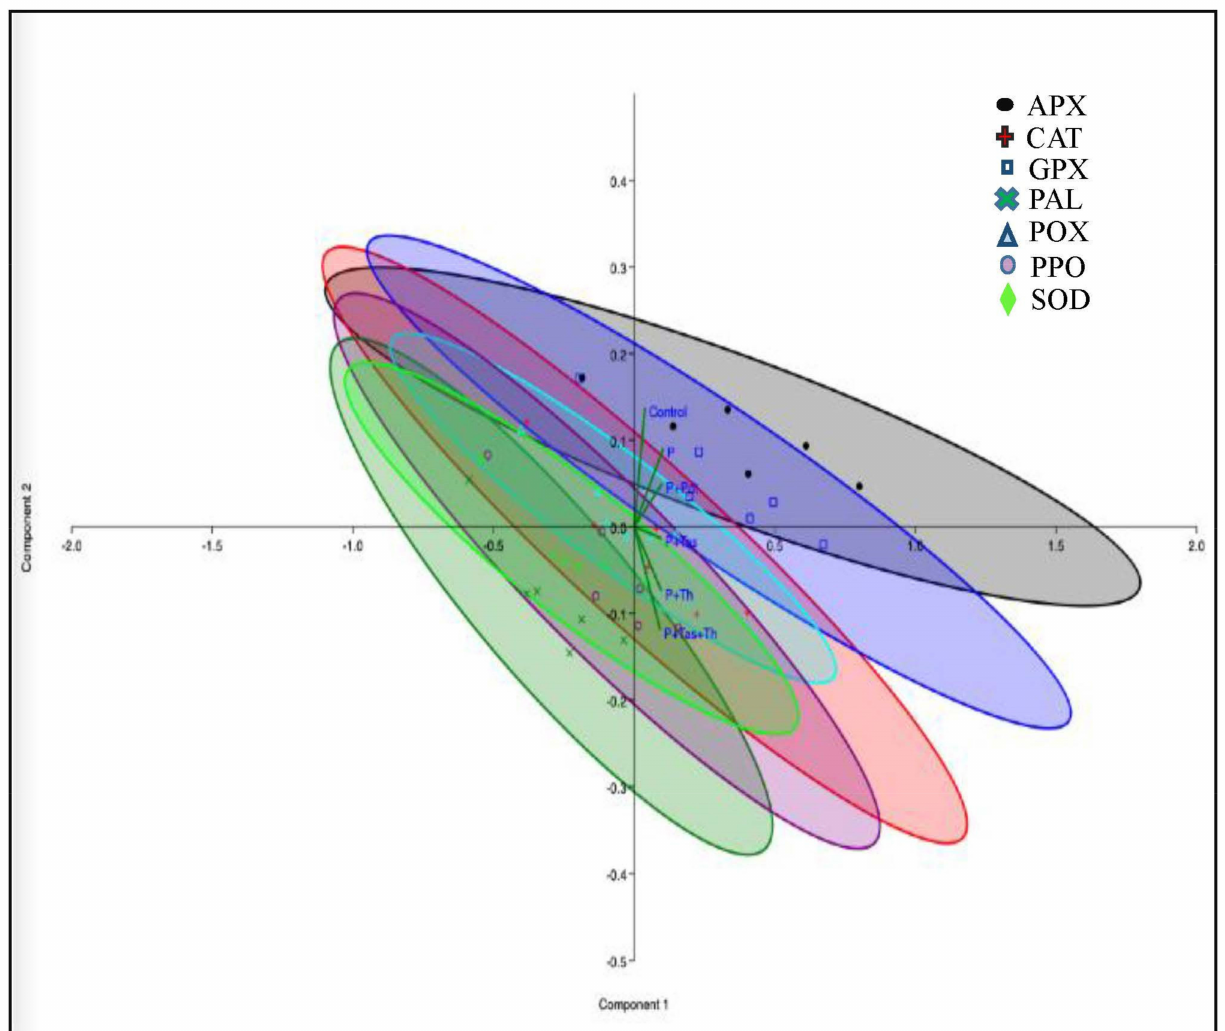
Figure 16. Principal component analysis (PCA) of chilli fruits treated with bioagents under pathogen-challenged, untreated and unchallenged as negative control, and untreated and pathogen-challenged condition as positive control were harvested at different time intervals like 0, 12, 24, 48, 72, and 96